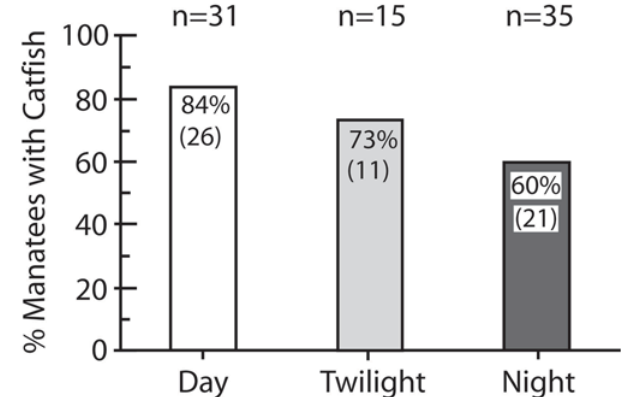
Fig. 3. Histogram comparing proportion of manatees with one Fig. 2. Box plot illustrating the diel activity pattern of non- or more attached Pterygoplichthys during each of the three native Pterygoplichthys in Volusia Blue Spring (Florida) based on numbers of catfish per manatee. Columns represent results major diel periods. Information based on results of direct of the 10 observation sessions conducted over a 24-h period observations conducted at Volusia Blue Spring (Florida) over spanning 10-11 December 2009. Box-whisker plot composed of a single 24-h period spanning 10-11 December 2009. Each quartiles, central horizontal line = statistical median; diamond column represents pooled data from multiple observation = mean; box encloses 25-75 percentiles; whiskers represent 0- sessions: Day = 5 sessions; Twilight = 2 sessions ( i . e ., dusk and dawn); and Night = 3 sessions). Numbers of manatees 25 and 75-100 percentiles, terminating in least and greatest included in each session are given above columns. Chi-square observed values. Sample size above each column represents (3 x 2 comparison) test indicated no statistical difference number of manatees included in survey. No significant between major diel period and the proportion of manatees difference were detected across observation sessions: Kruskal- (corrected for ties) = 7.132, p 0.6233. with armored catfish ( χ 2 = 4.634, df = 2, p = Wallis, H 9